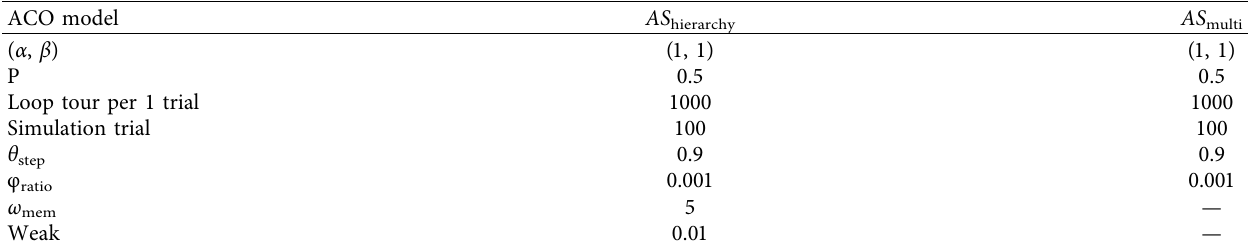
Figure 1: Flowcharts of AS hierarchy . (a) A tour iteration. (b) The pheromone update after each iteration. Note that ratio can be ratio � | l x ( s,t ) − l y ( s,t )| / l x ( s,t ) + l y ( s,t ) , where l x ( s , t ) and l y ( s , t ) means accumulated tour length of agent x and y at step s . L x means tour length of solution the agent x found. Table 1: Parameter settings.